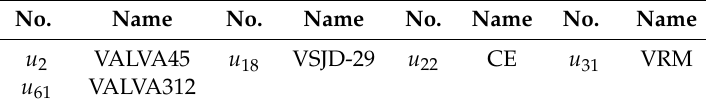
Table 4. Structural actuators (towards demand nodes).